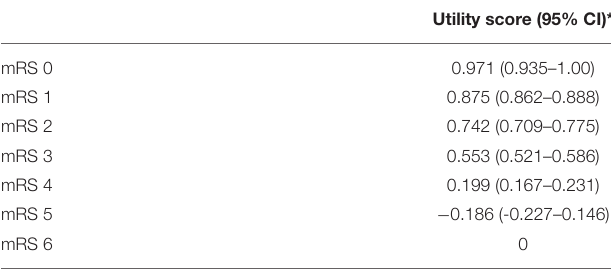
TABLE 3 | Utilities.